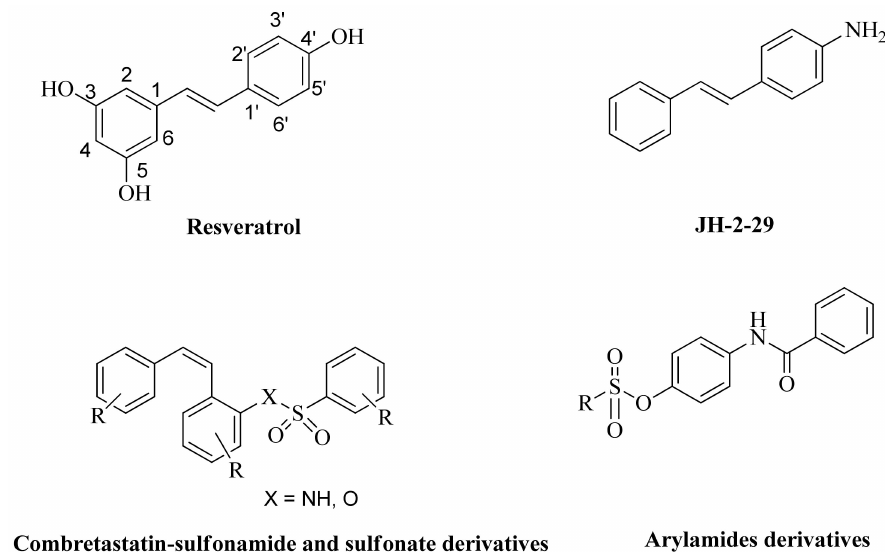
Figure 2. Structures of RSV, JH-2-29, and some sulfonate and sulfonamide RSV